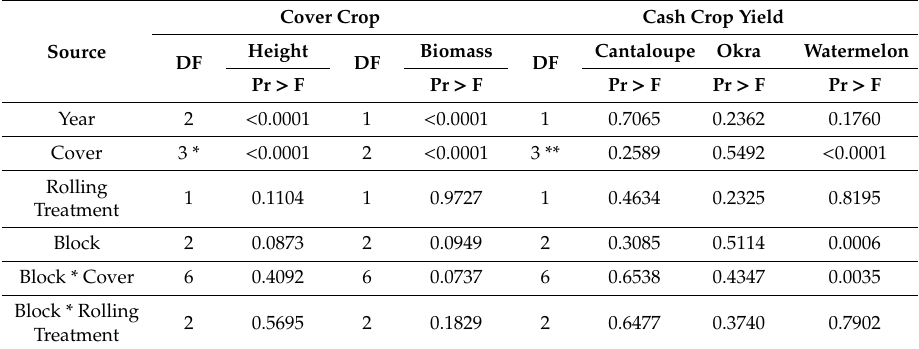
Table 2. Fixed e ff ects of ( p values) for dependent variables utilized in this study.